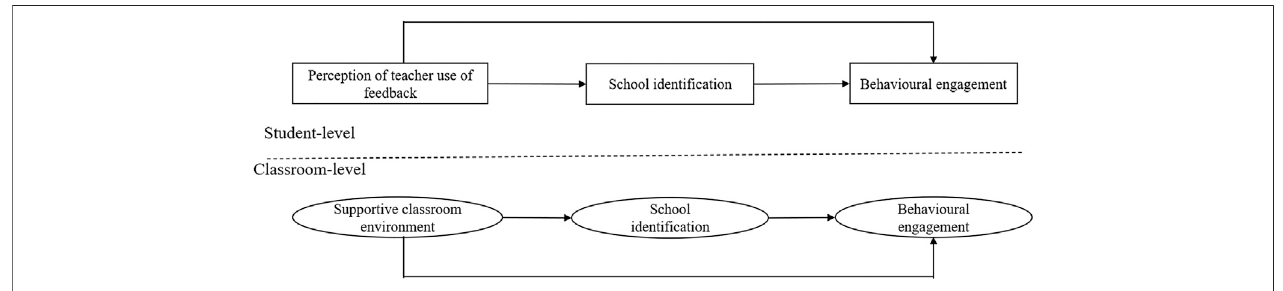
FIGURE1| Conceptual model. Latent classroom-level constructsare represented ascircles, and student-levelindicatorsoftheselatent variablesare represented as